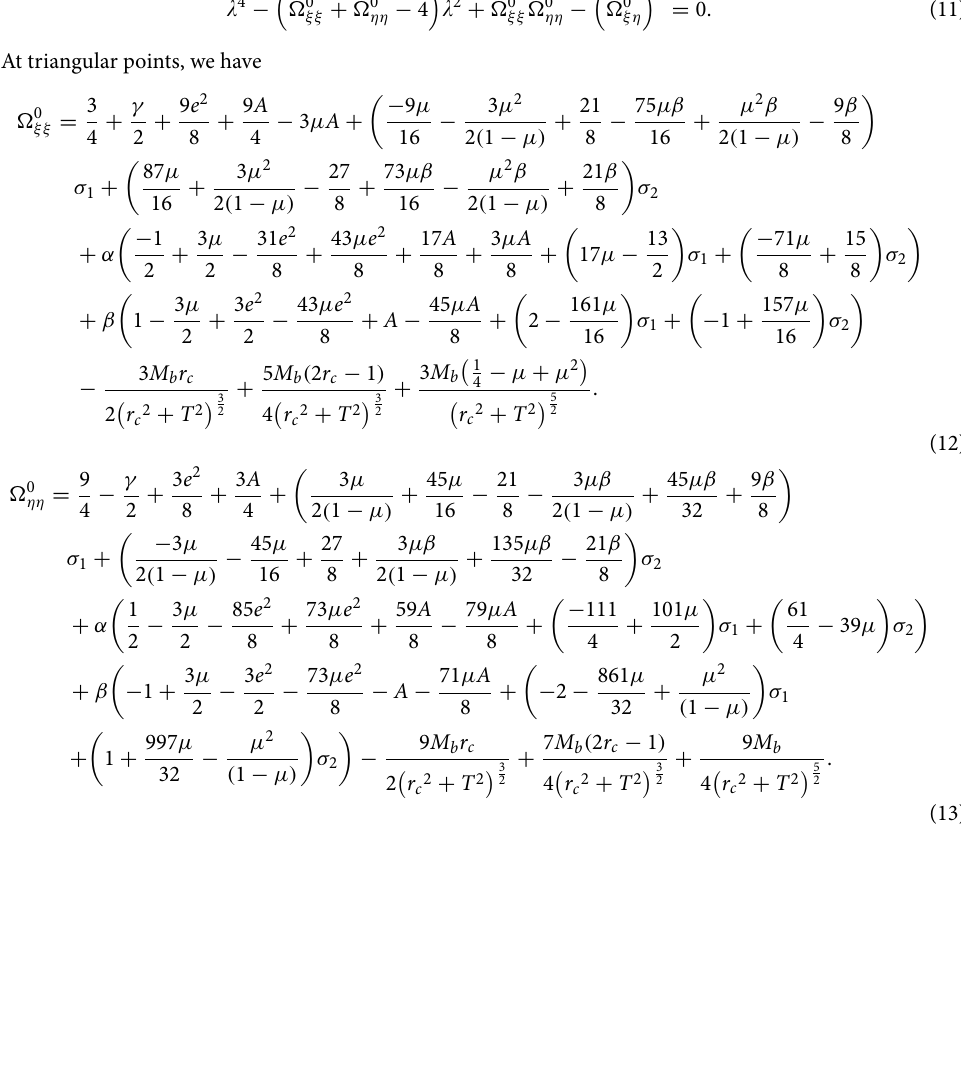
Table 4 and Fig. 9 show the effects of oblateness, Eccentricity of orbits, semi-major axis, Albedo parameters, triaxiality, and the potential due to belt on the triangular libration points for the Earth–Moon system. The initial 1.5, 0 )) and (( 1.5, 0 ) , ( 1.5, 0 )) are used in plotting the graphs in Fig. 9 for the Earth–Moon conditions (( 1.5, 0 ) , ( − − system. The positions ( L 4 andL 5 ) of the triangular libration points are affected by the aforementioned parameters for the system under study. We have observed that as the parameters increase, the position L 4 and L 5 move towards the center of origin for cases 1, 2, 3, and 4 and away from the center of origin for cases 5, 6, and 7 for the Earth–Moon system (see Table 4 and Fig. 9). As the parameters increase, constant movement occurs except in case 5, as seen in Table 4 and Fig. 9, forming different